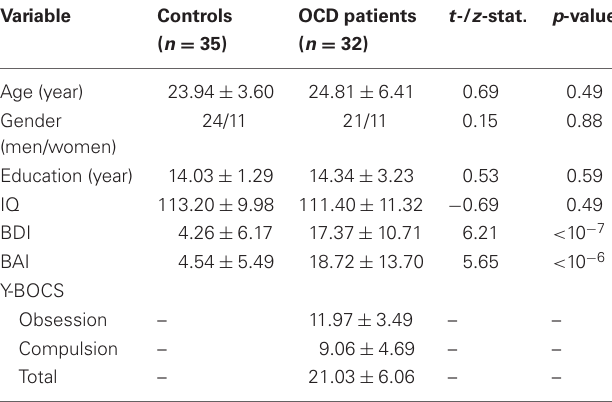
Table 1 | The summary of demographic and clinical